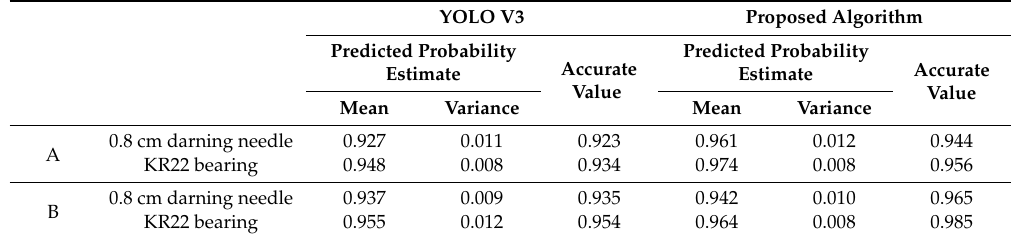
Table 5. Test results of the system for different